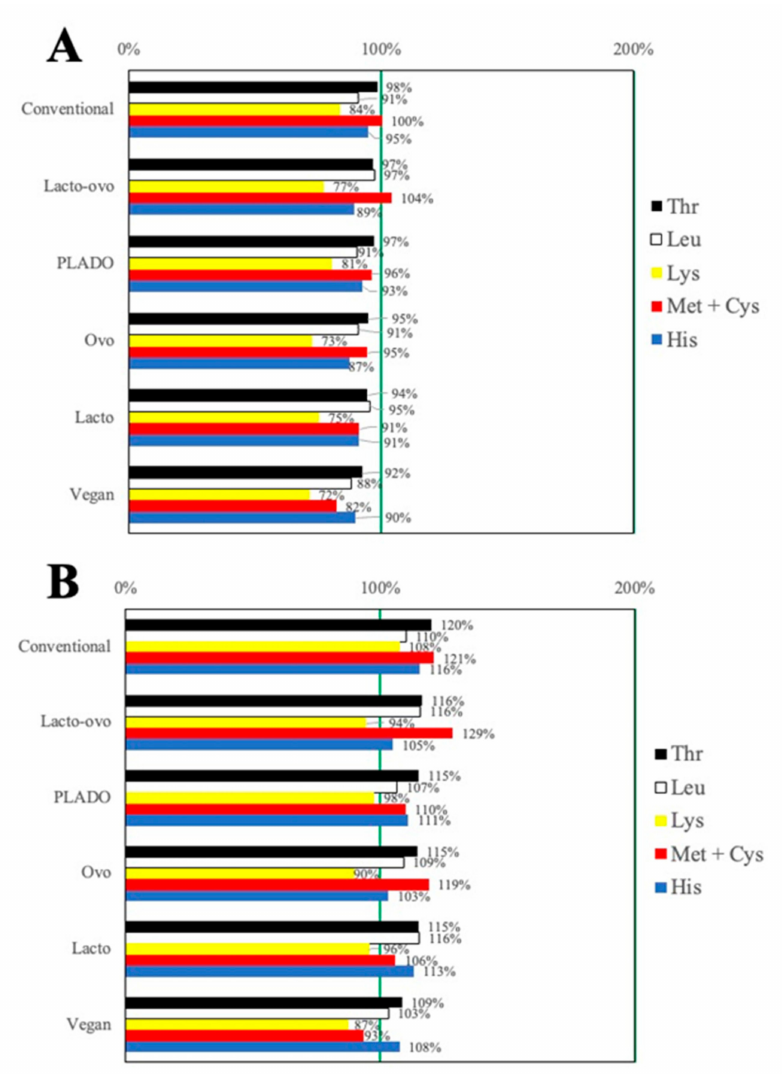
Figure 1. Percent of Recommended Dietary Allowance of selected essential amino acids for con- ventional, plant-based, and vegetarian diets at the protein prescription of ( A ) 0.5 g/kg/day and ( B ) 0.6 g/kg/day. Abbreviation: PLADO, plant-dominant. Amino acid abbreviations: Cys, cysteine; His, histidine; Leu, leucine; Lys, lysine; Met, methionine; Thr, threonine. Other essential amino acids such as tryptophan, isoleucine, phenylalanine, tyrosine, and valine are not included because all low protein diets meet the Recommended Dietary Allowance.